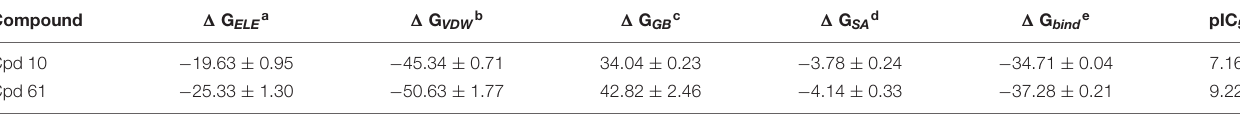
TABLE 3 | Binding free energies (kcal/mol) for JAK3-inhibitor complexes using the MM/GBSA method along with specific energy contributions. Compound